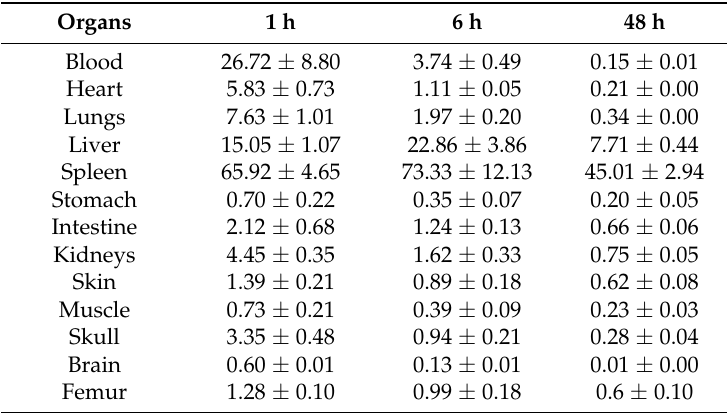
Table 1. Biodistribution of tail-vein injected [ 111 In]-Liposome (1.07 MBq ± 0.03) in nude mice ( n = 3) per time